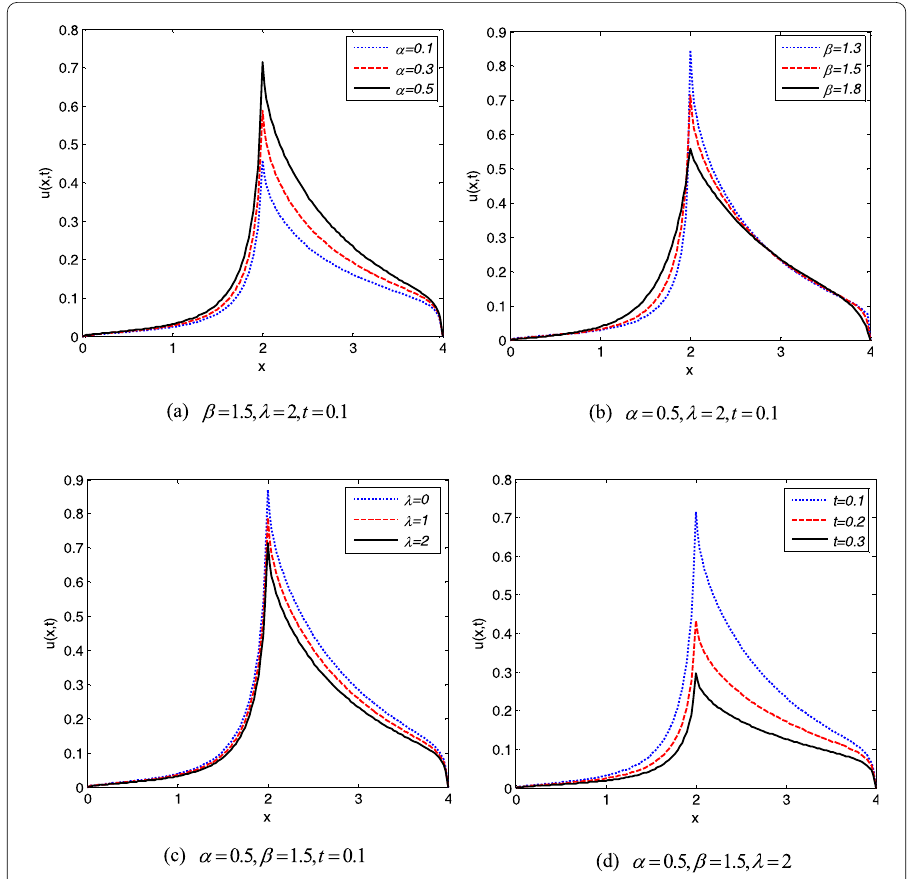
Figure 1 The probability density distribution of particles under different values of α , β , λ , t